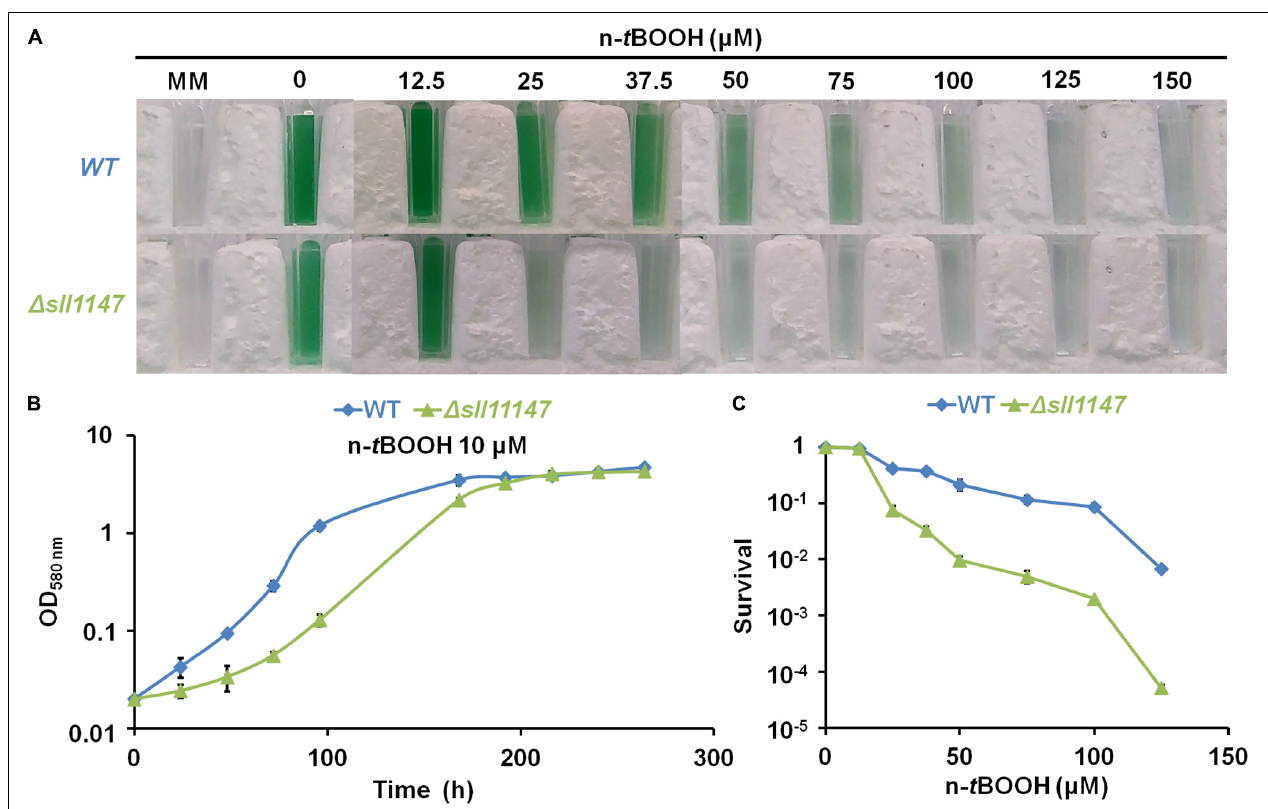
FIGURE 2 | The (cid:49) sll1147 mutant is sensitive to n- tert butyl hydroperoxide. (A) Ten milliliters of mid-log-phase cultures (initial OD 580 nm = 0.1) were incubated for 72 h in liquid mineral medium (MM) under standard photoautotrophic conditions with or without the indicated concentrations of n- t BOOH, prior to transfer in spectrophotometric cuvette and photography. (B) Typical growth curve of the WT strain and (cid:49) sll1147 mutant incubated in liquid MM containing 10 µ M n- t BOOH. (C) Typical survival of WT and (cid:49) sll1147 cells exposed for 72 h to various n- t BOOH concentrations. Data shown in (B,C) are expressed as the mean ± standard deviation (SD) of three